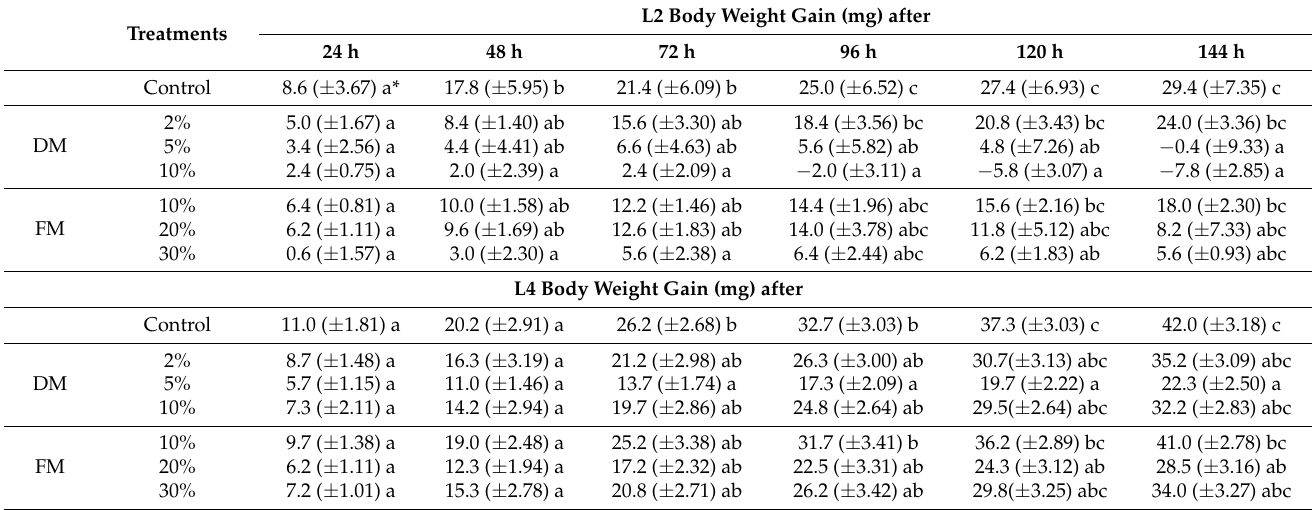
Table 3. Body weight gain of Leptinptarsa decemlineata (Say) larvae [mg] after the application of the water extracts made from the fresh (FM) and dried (DM) parts of tarragon.